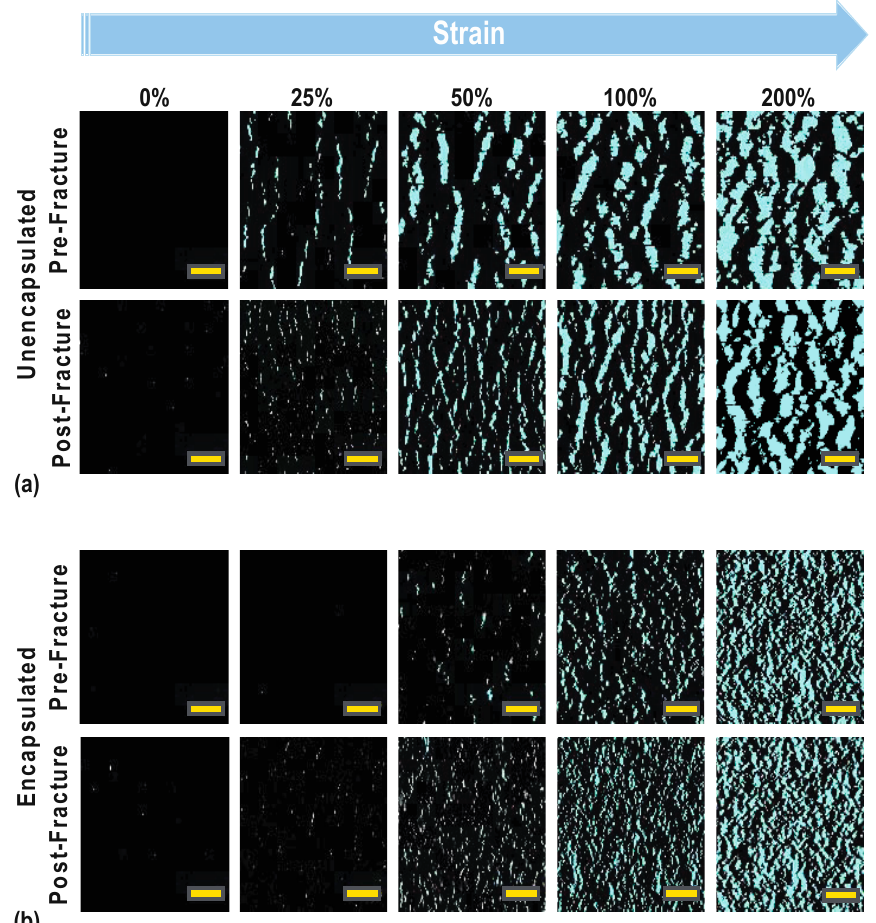
Figure 5. Bright field images of the crack evolution pre-and post-fracture for an unencapsulated ( a ) and encapsulated ( b ) sensor, respectively. Scale bar is 100 μ m for each panel. Cracks have been pseudo-colored for better visualization purposes of this figure. All image analysis was done on non-colored, unaltered